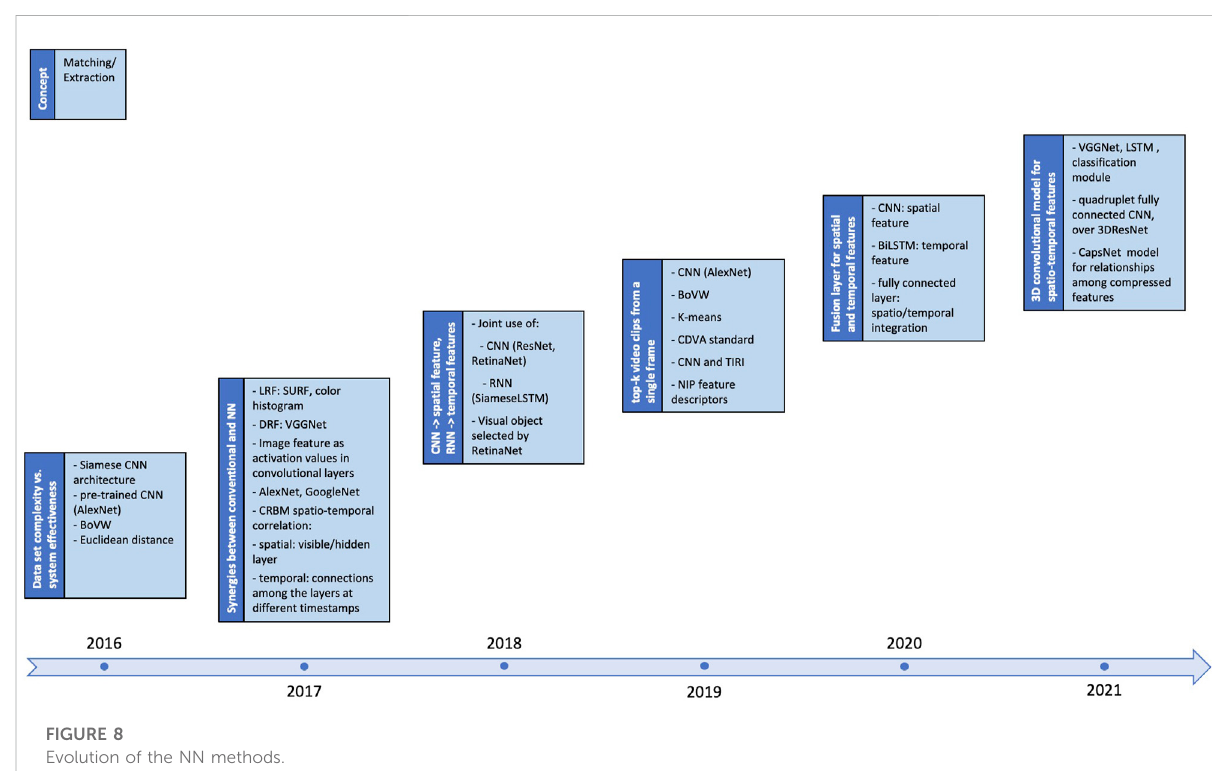
FIGURE 8 Evolution of the NN